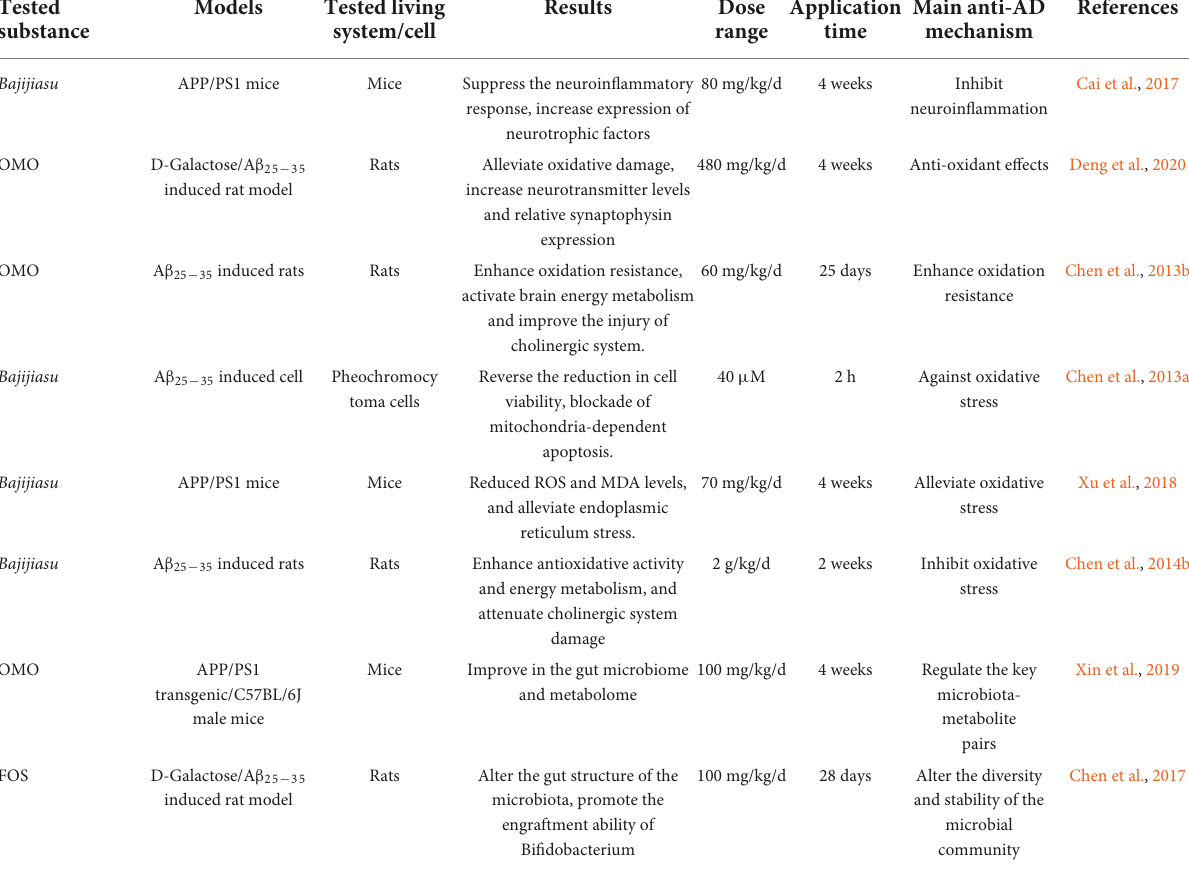
TABLE 1 Pharmacological activities of M. officinalis How. in AD treatment. Tested